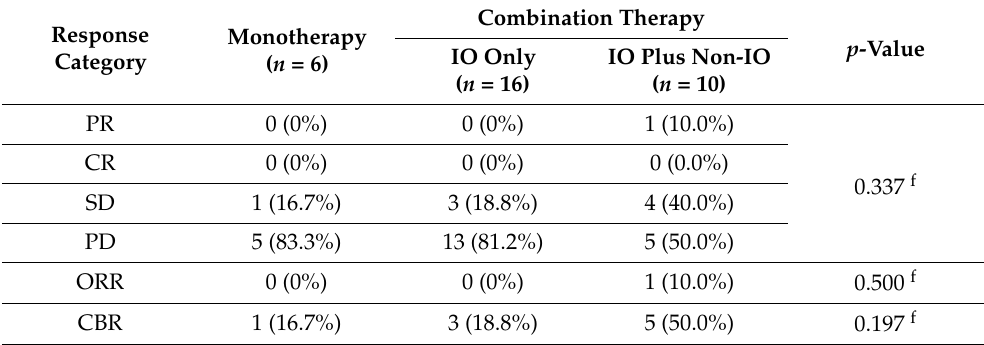
Table 2. Evaluable responses ( n = 32) to immunotherapy treatment in MSS endometrial cancer.